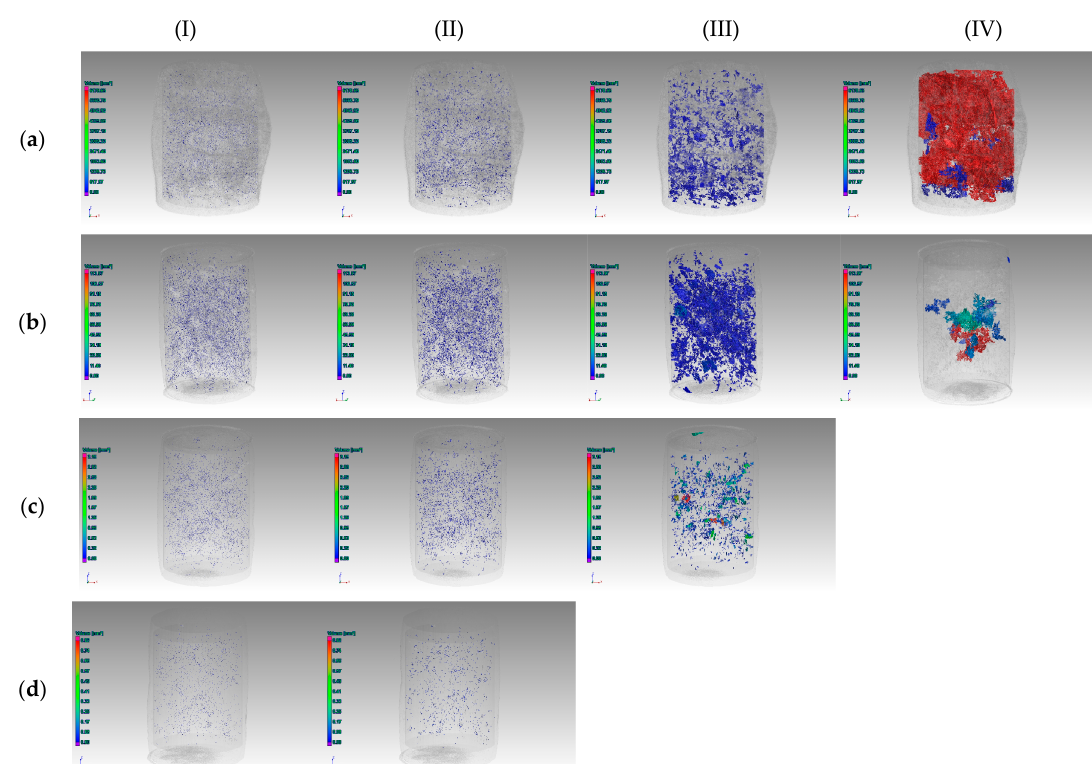
Figure 16. Crack analysis of pure salt after failure under different confining pressures. ( a ) σ 3 = 5 MPa (SR-1); ( b ) σ 3 = 10 MPa (SR-5); ( c ) σ 3 = 15 MPa (SR-6); ( d ) σ 3 = 20 MPa (SR-7).